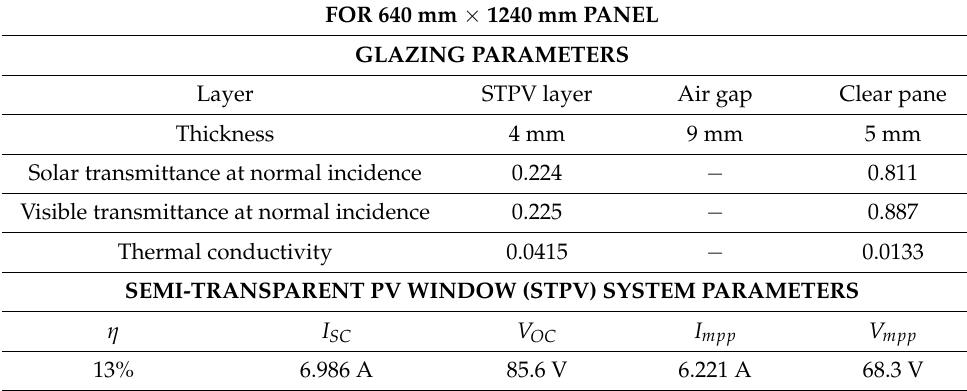
Table 12. PV window specifications